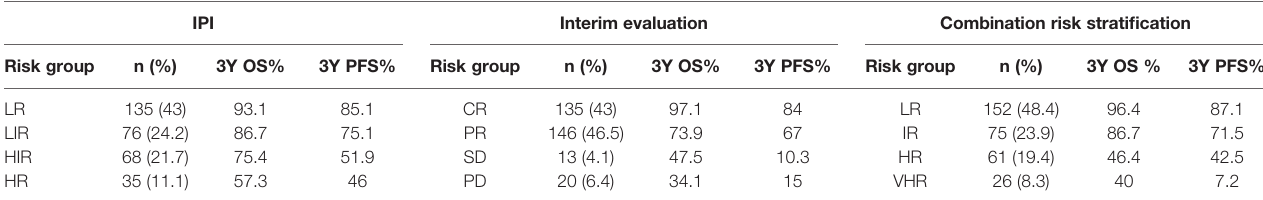
TABLE 3 | Distribution and survival of the patients in the different risk groups.